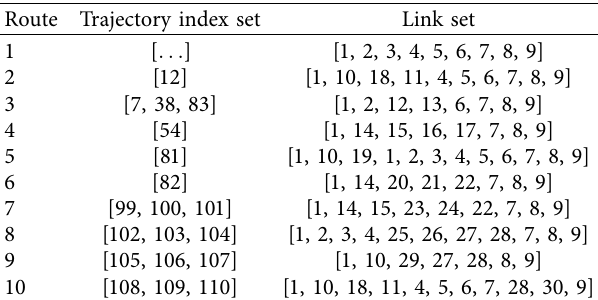
Table 4: The trajectory index set and link information regarding OD 1